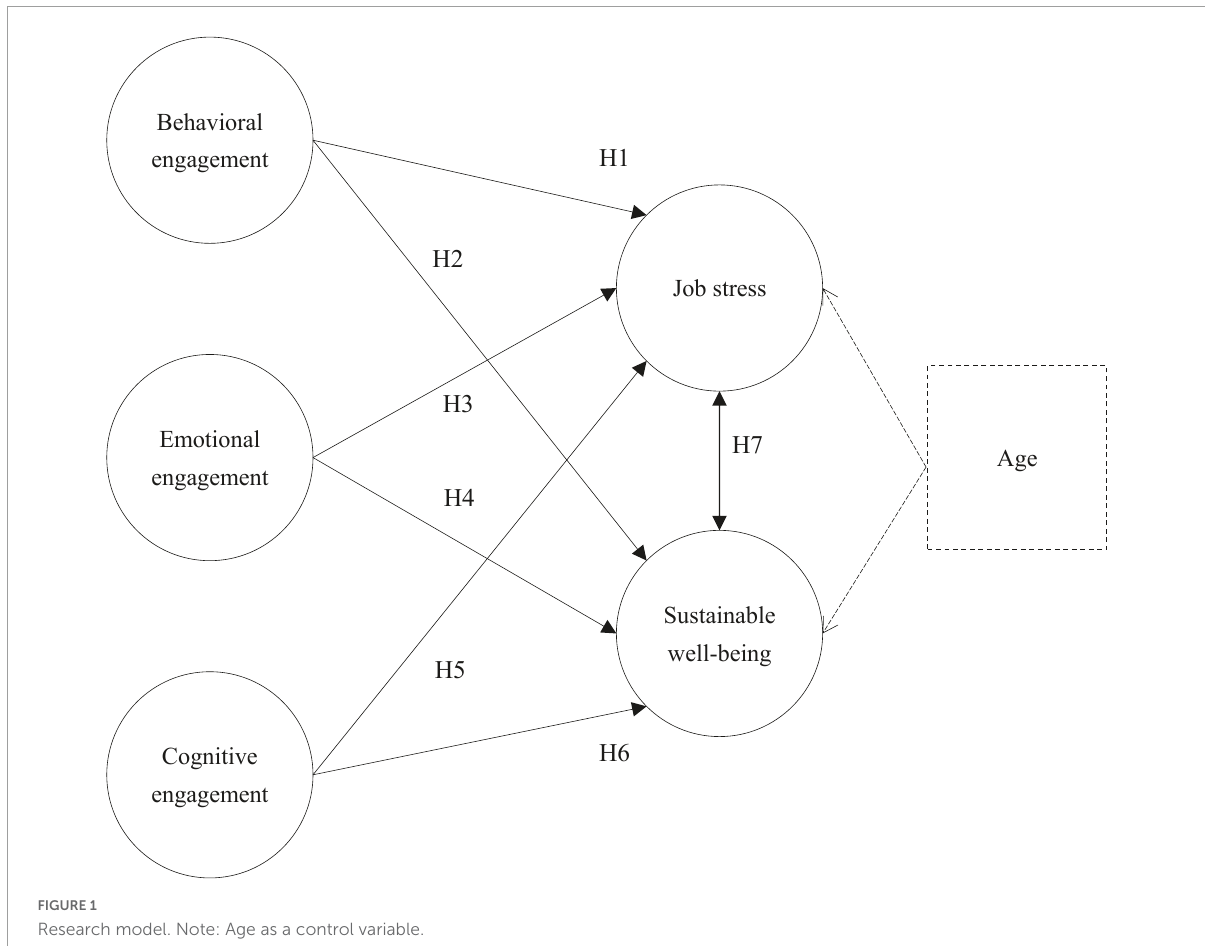
FIGURE1 Research model. Note: Age as a control